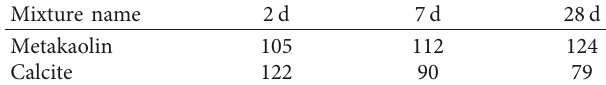
Table 4: Pozzolanic activity results for MK and C